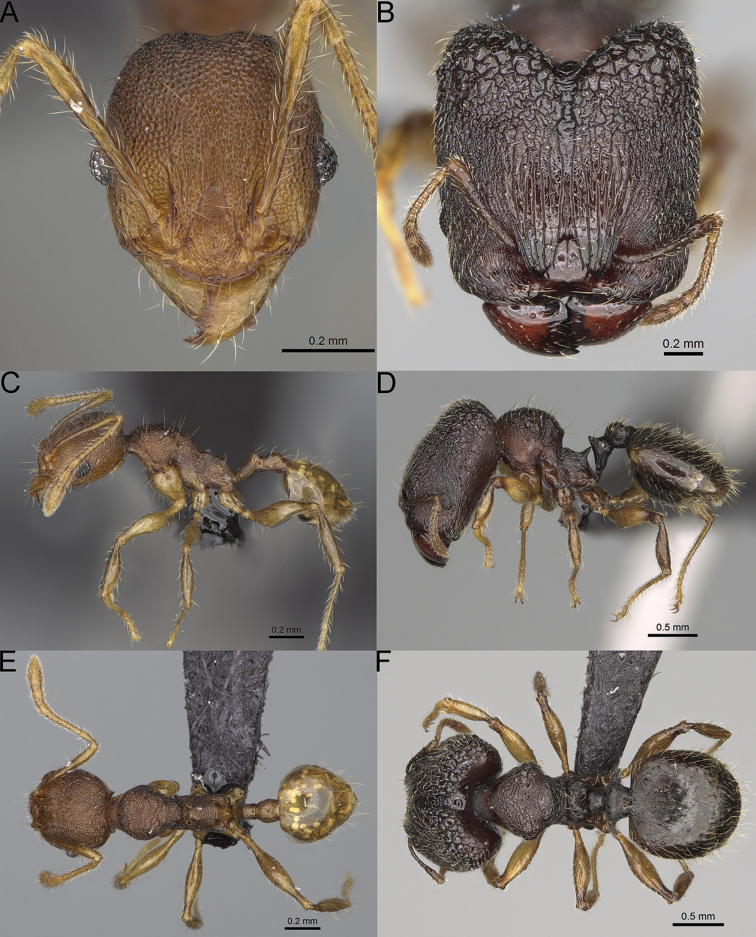
Pheidole
brevipilosa sp. nov., full-face view (A), profile (C), and dorsal view (E) of paratype minor worker (CASENT0134271) and full-face view (B), profile (D), and dorsal view (F) of holotype major worker (CASENT0235034).